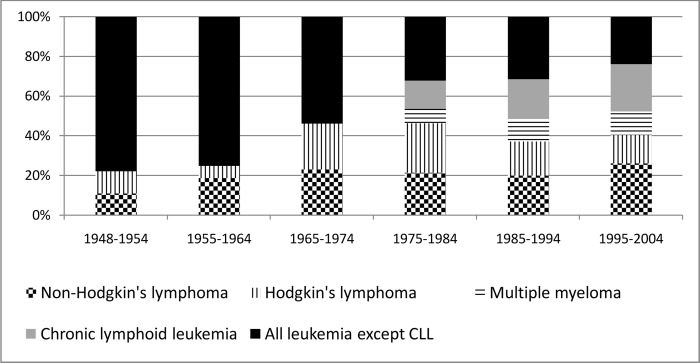
The distribution of diseases by calendar period between 1948–2004.